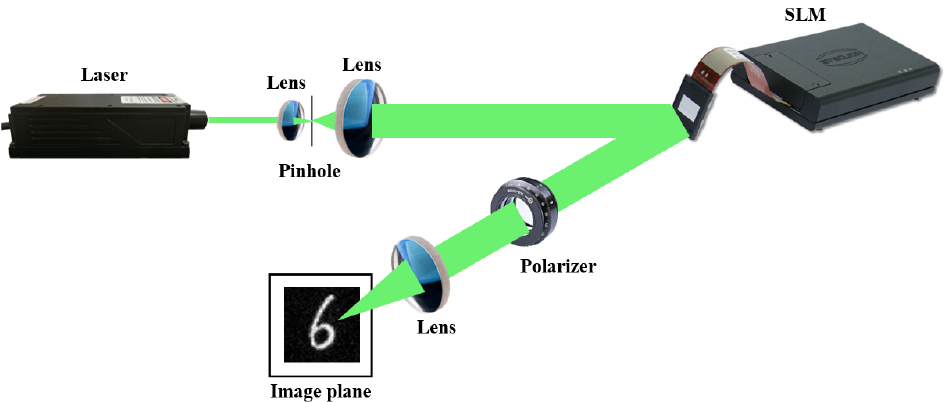
Figure 1. Optical setup of ECGH reconstruction.